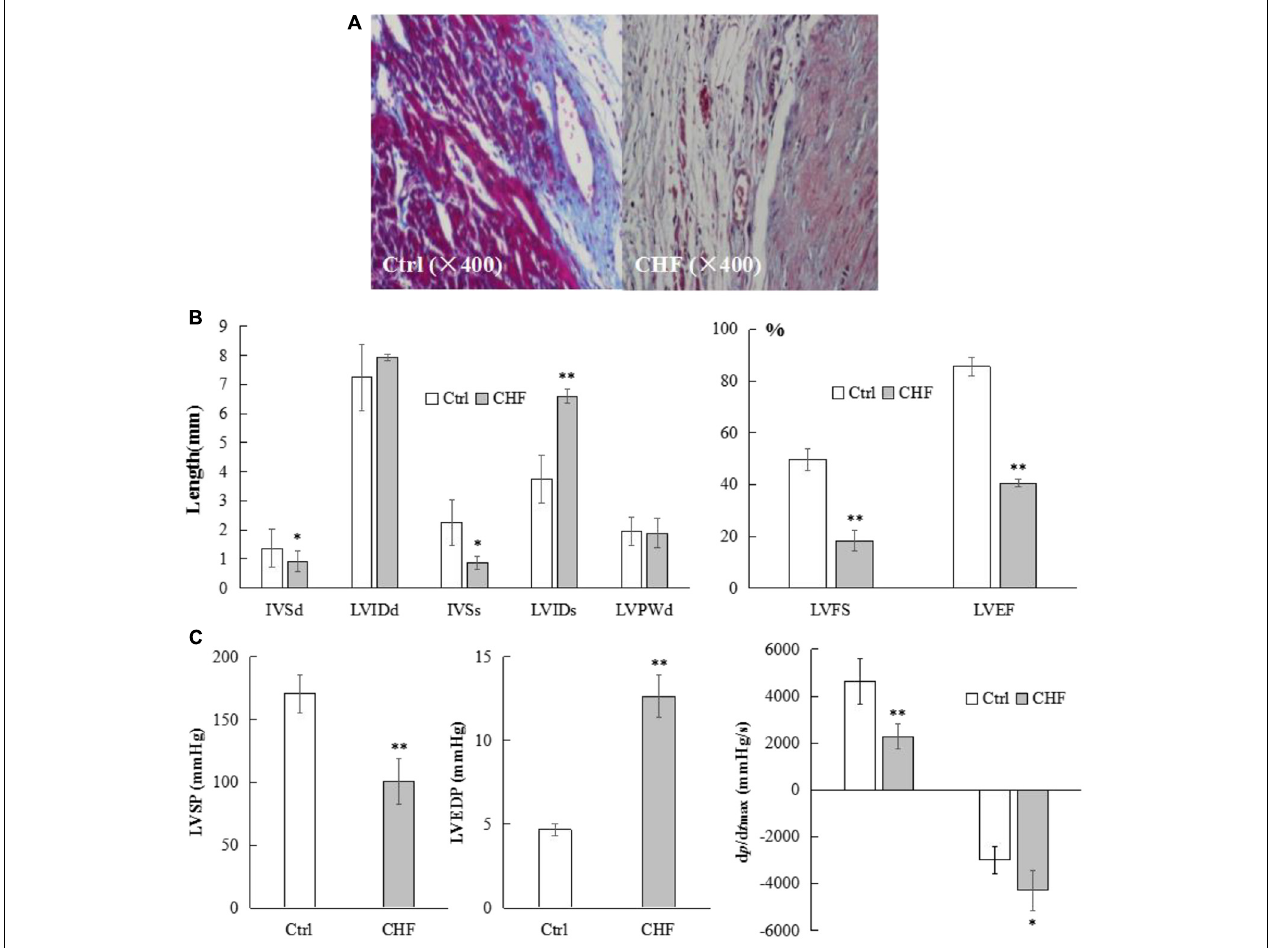
FIGURE 11 | Microscopic morphological, general structural and functional alterations in the heart of CHF model rats. (A) Microscopic view (400 × ) of representative myocytes in control and CHF by Masson staining ( n = 10). Most myocytes in the control exhibited relatively clean and neatly ordered muscular stripes (red dyed) with less collagen fibers (blue dyed) and nuclei, whereas the CHF myocytes exhibited more messy, unordered, cord-like collagen fibers instead of stripes, where some collagen fibers were found to be wrapped together in masses, forming flakes. In the CHF rats, very few complete muscular fibers were identified under high magnification. (B) The histograms comparison of cardiac structure parameters in control and CHF rats ( n = 25) measured by Doppler ultrasound. The IVSd and IVSs in the CHF group were thinner than those in the control group ( ∗ P < 0.05), while the LVIDs was significantly thicker in the CHF group than in the control group ( ∗∗ P < 0.01). The LVIDd did not differ between the two groups. The LVFS and LVEF values were lower in the rats with CHF than in the control rats ( ∗∗ P < 0.01). (C) The histograms comparison of hemodynamic parameters in control and CHF rats ( n = 17) by right carotid artery catheterization into the left ventricle. LVSP, +d p /d t max and –d p /d t max in CHF group rats decreased significantly ( ∗ P < 0.05, ∗∗ P < 0.01), whereas LVEDP in CHF group rats increased significantly ( ∗∗ P < 0.01), compared with the control group